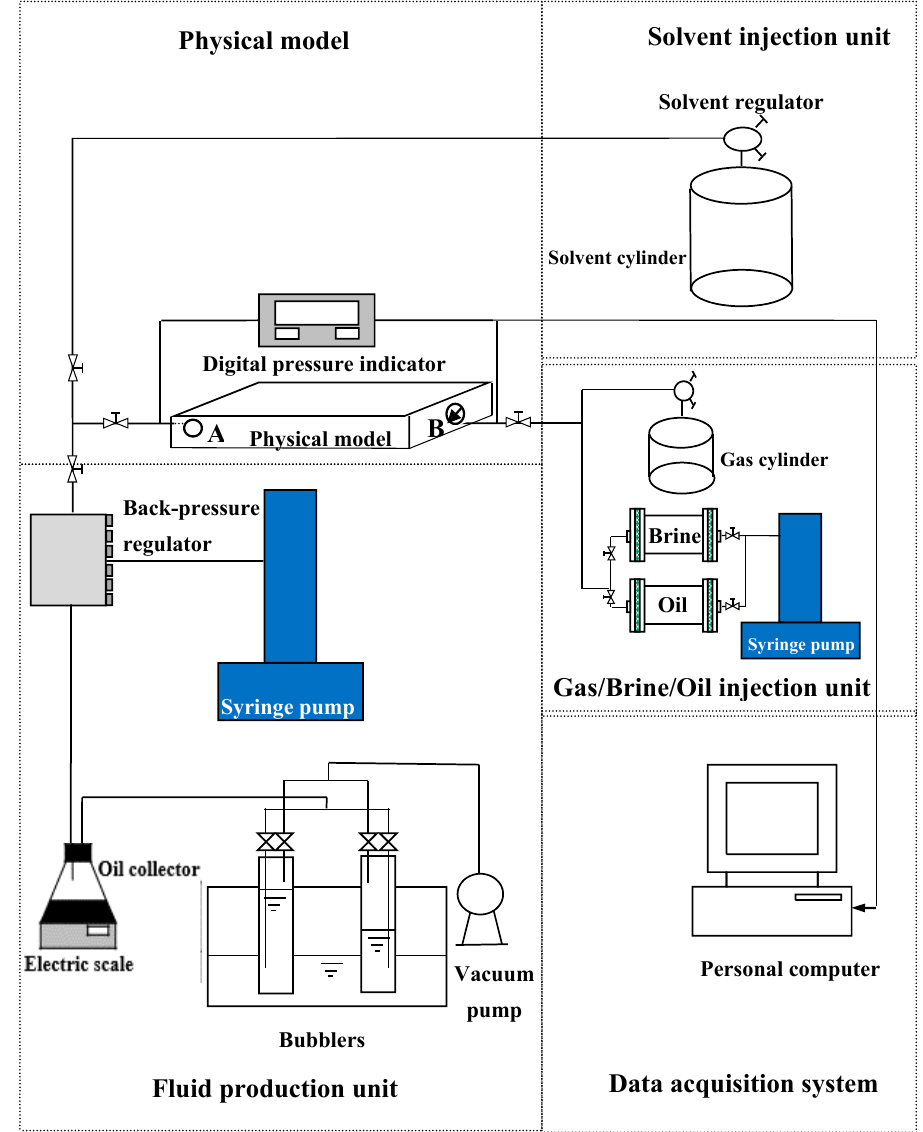
Figure 1. Schematic diagram of the experimental set-up used for conducting the primary production and the subsequent CSI / GPC / SA-GPC (cyclic solvent injection / gas pressure cycling / solvent-assisted gas pressure cycling).